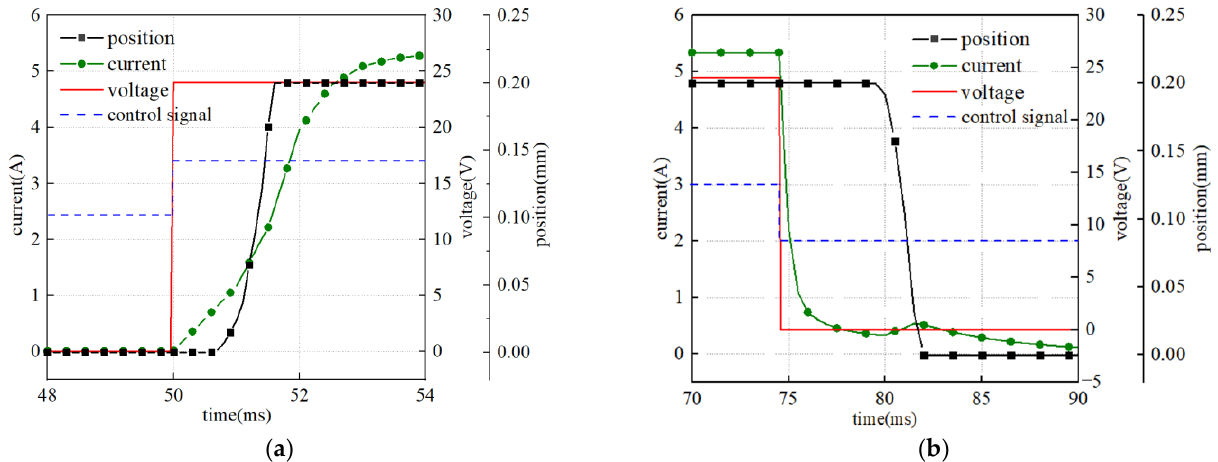
Figure 4. The dynamic characteristics’ curve in single voltage strategy: ( a ) Opening process; ( b ) Closing process.